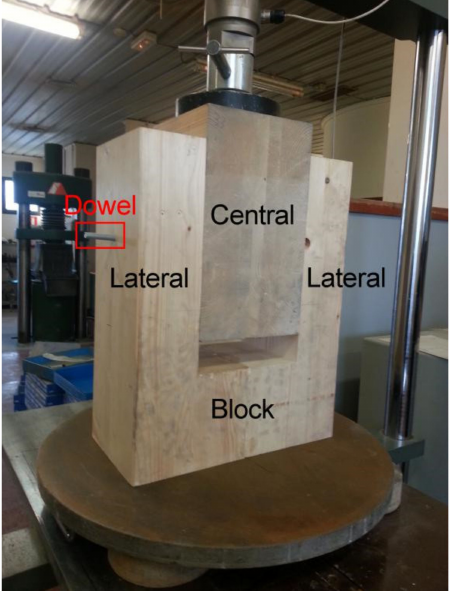
Figure 10. Specimen in the test